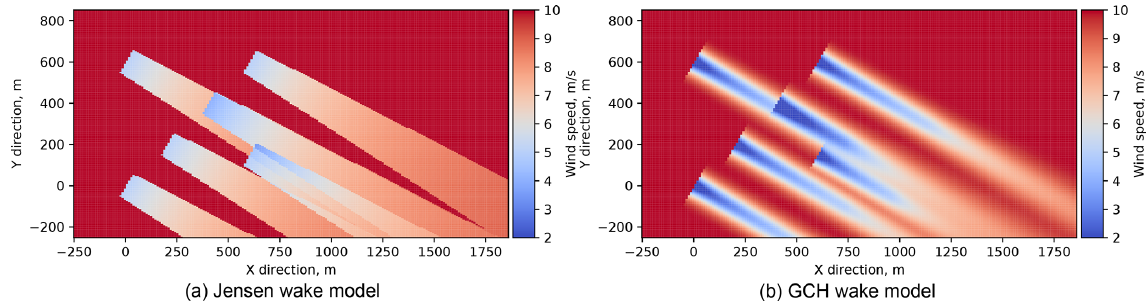
Figure 9. Simplistic velocity deficits of the Jensen wake model (Jensen, 1983) (a) versus the more accurately resolved flow field of the GCH model (King et al., 2021) (b) .